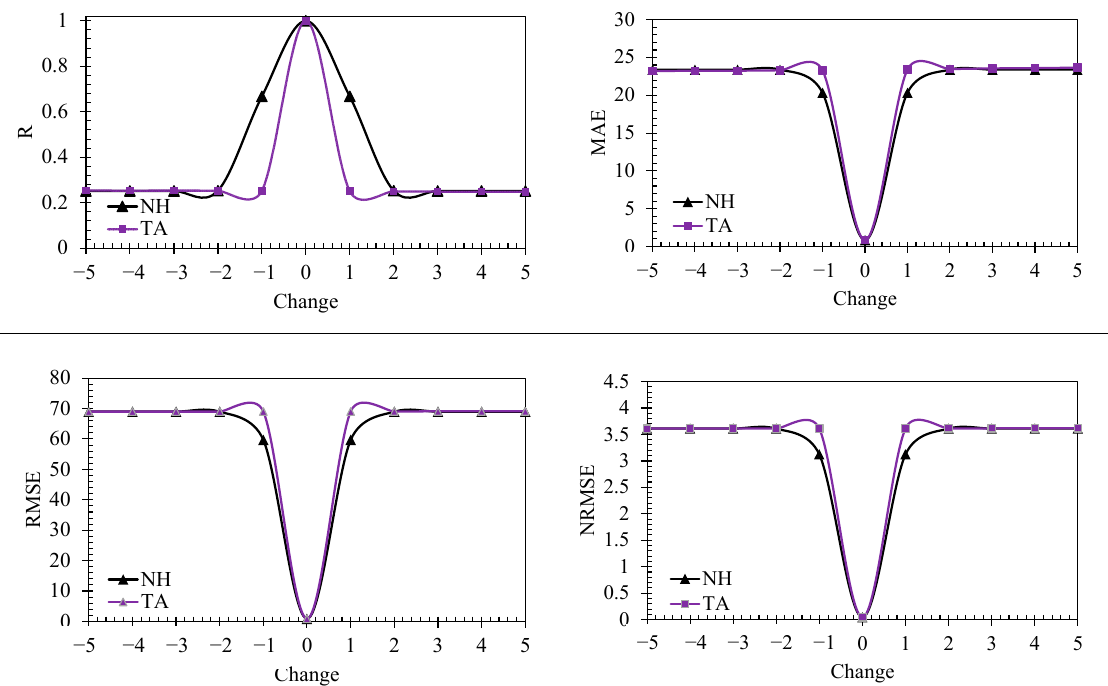
Figure 9. The impact of changes in input variables on the performance of the developed RF-SVM- GOA.